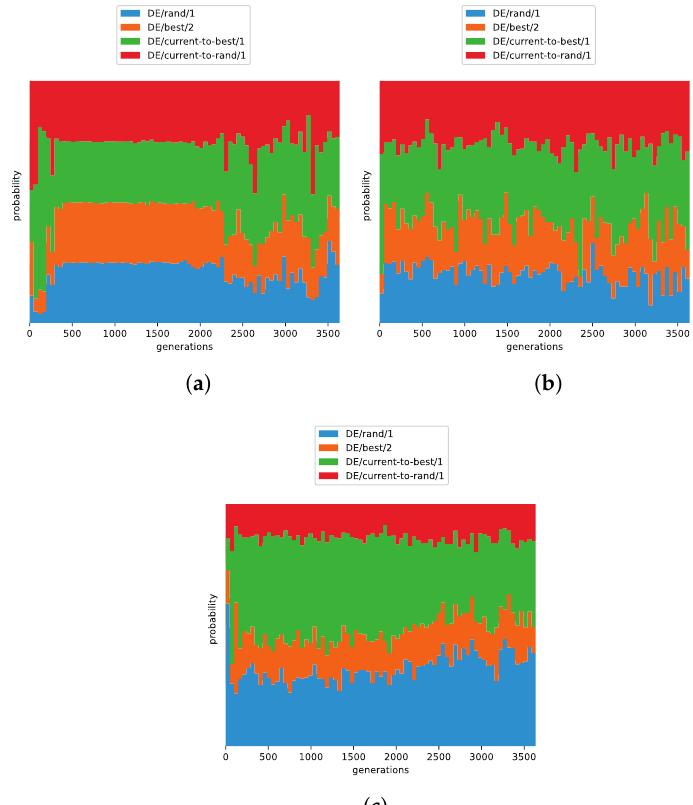
Figure 4. Probability-assignment methods’ performances in F5 (Rosenbrock benchmark function). The probability is depicted in a relative plot, so a color’s thickness represents the probability of the given search method’s assignment. Note that the sum of the assignment probabilities in each genera- tion must be 1. ( a ) Larval-raw-fitness probability-assignment method. ( b ) Larval-fitness-improvement probability-assignment method. ( c ) Larval-success-rate probability-assignment